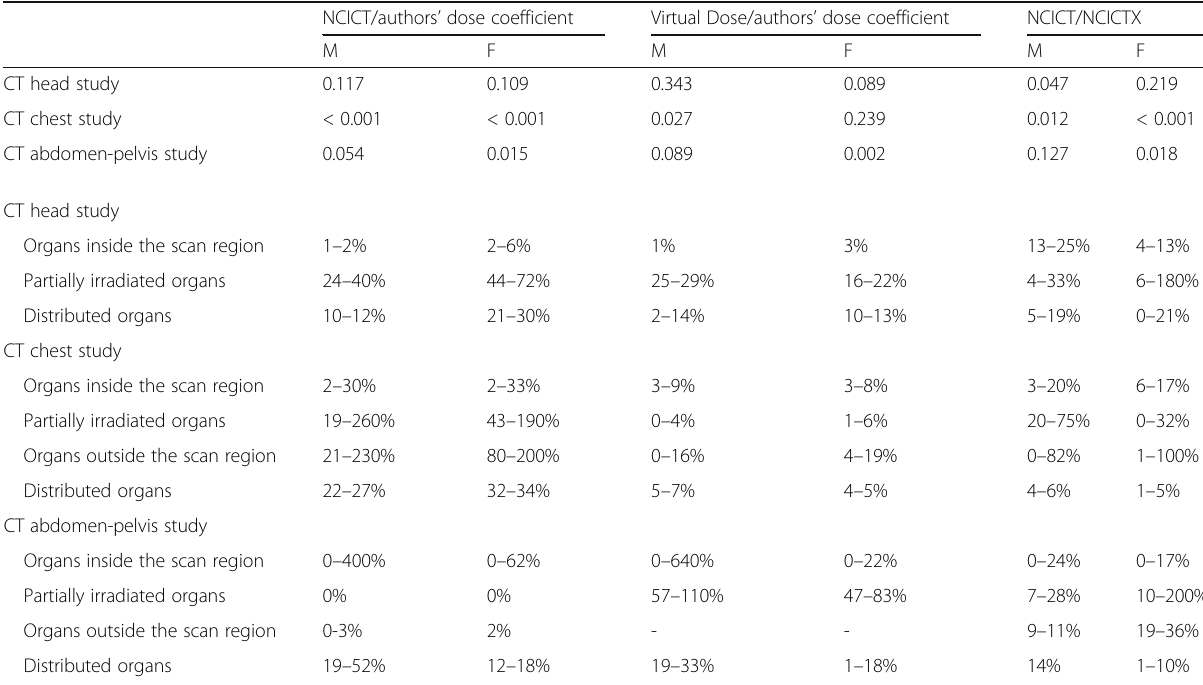
Table 5 Second level of analysis for NCICT and Virtual Dose software: comparison with authors ’ dose coefficients and between NCICT and NCICTX, for head, chest, and abdomen-pelvis scans (120 kV p ). For each body part and gender, we reported the results of the paired Student t test (top) and the range of the relative discrepancies for each class of organs (bottom). In the CT abdomen- pelvis scan, the authors of Virtual Dose software do not report the dose coefficient for the organs considered as outside the scan